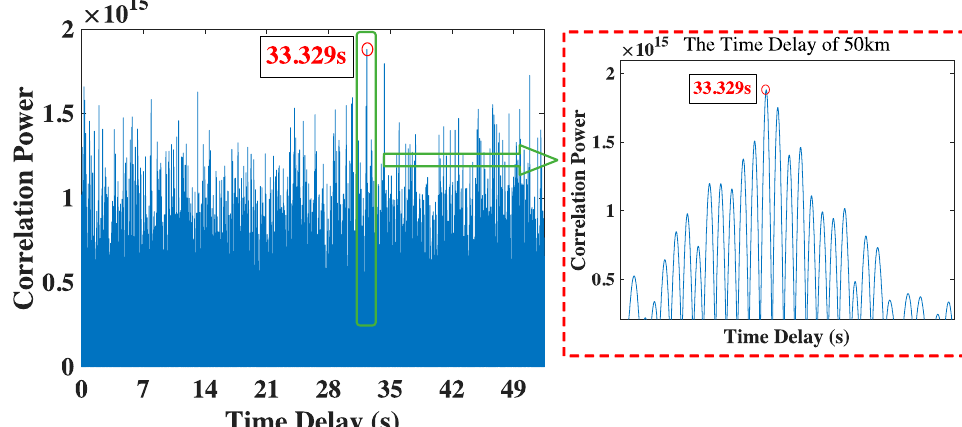
Figure 9. The time delay results of 50 km.